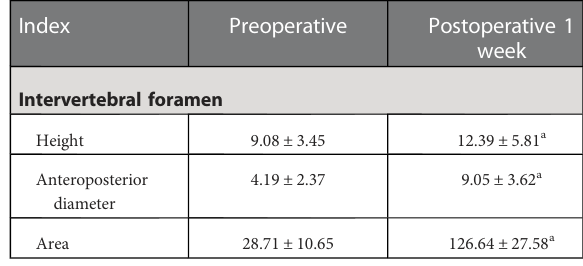
TABLE 3 Comparison of intervertebral foramen parameters before and after